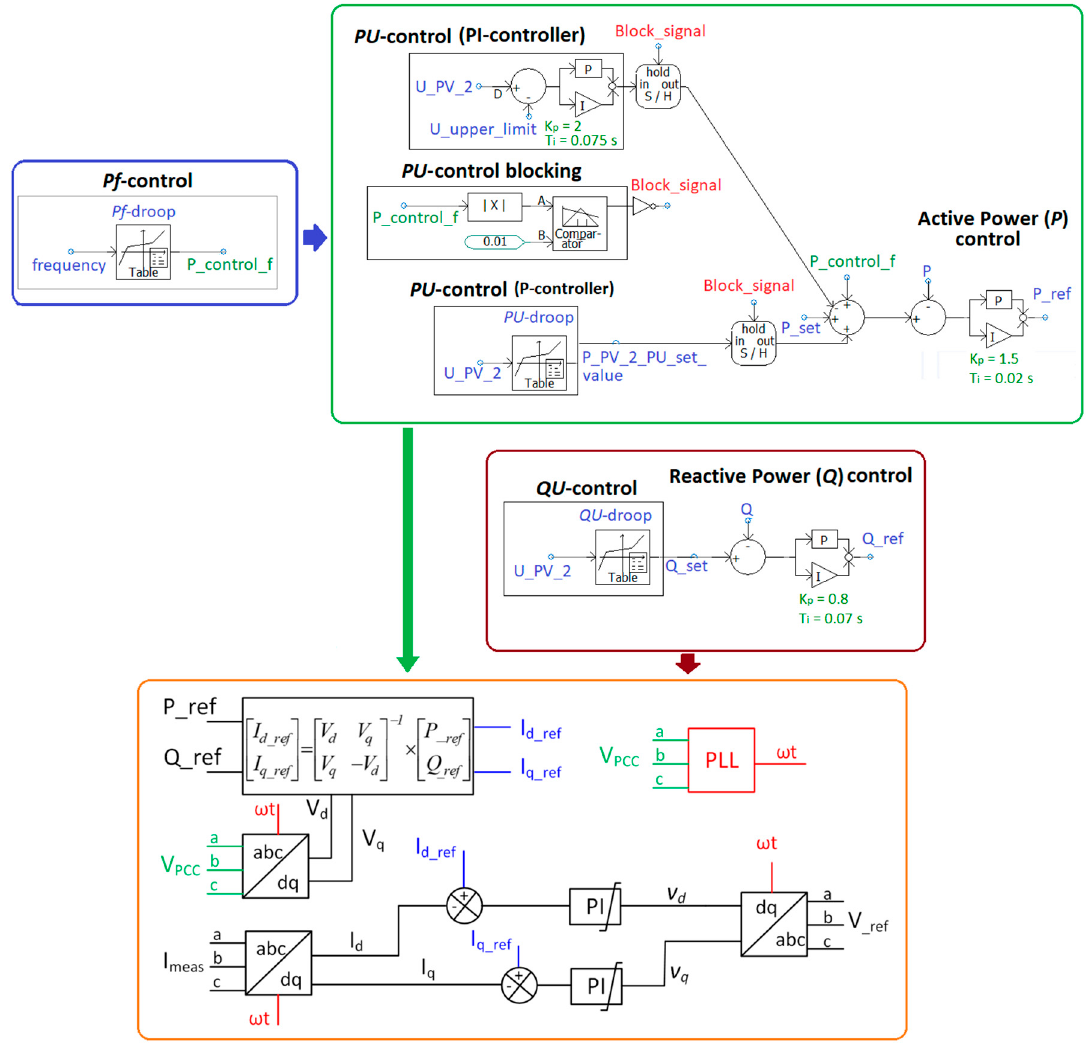
Figure 3. PV unit’s active and reactive power control functions like QU -, PU -, and Pf -droops implementation in PSCAD model (see also Figures 1 and 2).